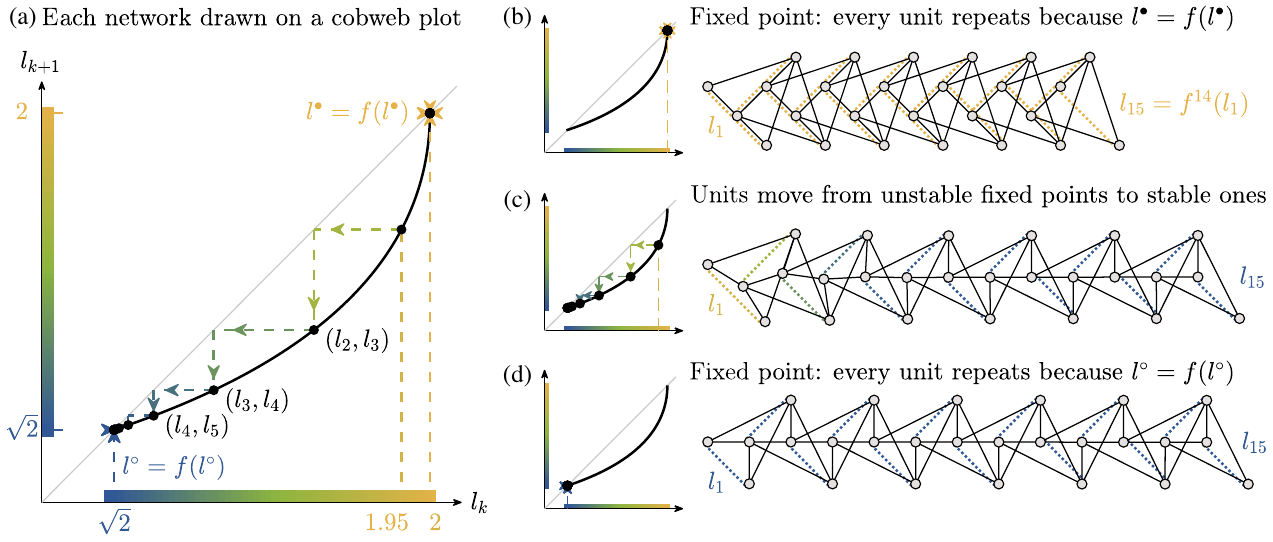
FIG. 5. Shape and folding sequence of iterated maps. (a) Plot of the curve l k cobweb plots drawn at initial lengths of l 1 ¼ 2 , 1.95, and units k also have the identical shape l k ¼ 2 because f ð 2 Þ ¼ 2 . In diagram (c), at an initial length of units are no longer identical, and they converge towards the stable fixed point at l ∘ ¼ all subsequent units k also have the identical shape l k ¼